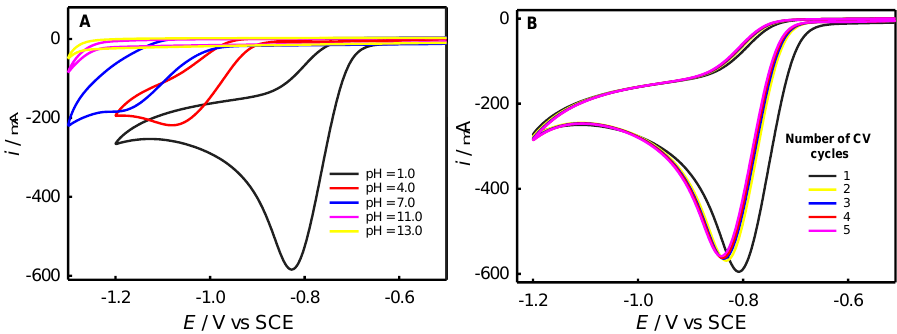
Figure 1. ( A ) CV curves of 10 mM cPy on GCE at different pH values. ( B ) CV curves of 0.1 M aqueous H 2 SO 4 containing 10 mM cPy on C-MWCNTs/GCE. C-MWCNTs/GCE and Py/C-MWCNTs/GCE were electrochemically characterized with redox probe 1.0 mM K 4 Fe(CN) 6 in 0.1 M phosphate buffer solution (PBS) at pH 7.0,